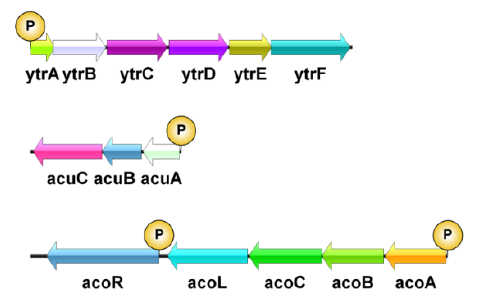
Figure 5. Gene clusters related to acetoin transport and degradation. The long arrowheads indicated the orientation and location of the ORFs, P: Transcription start site.